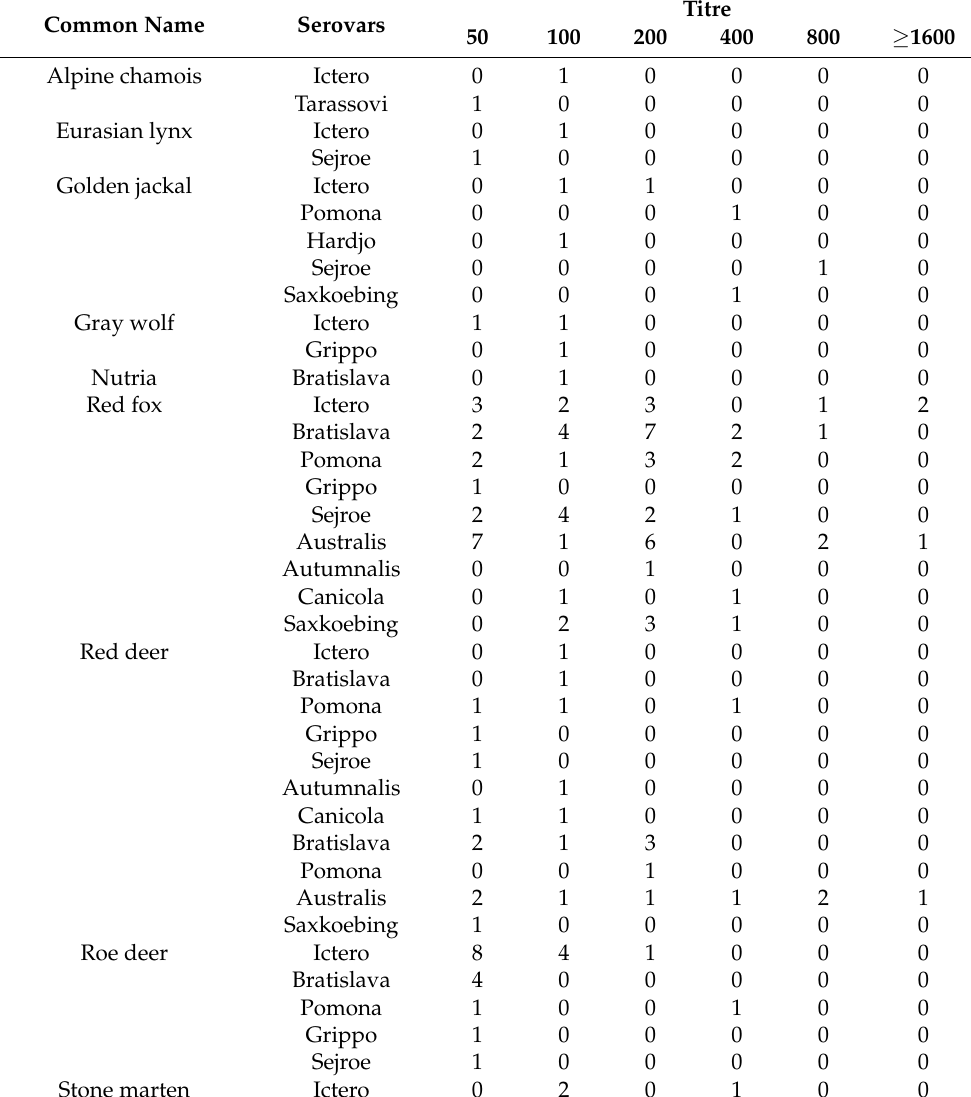
Table 3. Serovars and antibody titres against Leptospira serovars in tested wild